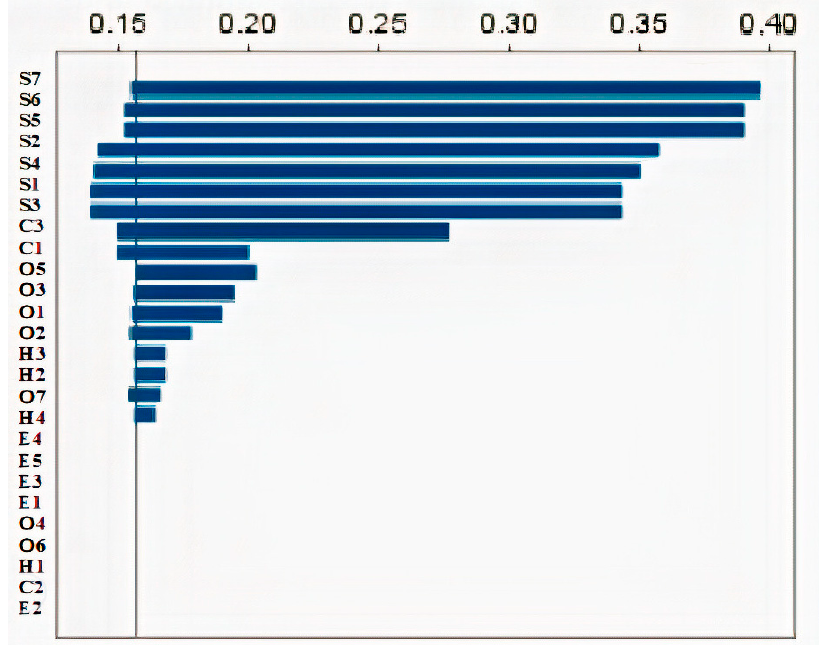
Figure 9. Tornado graph for sensitivity analysis of the risk of start-up Z—Risk4 .